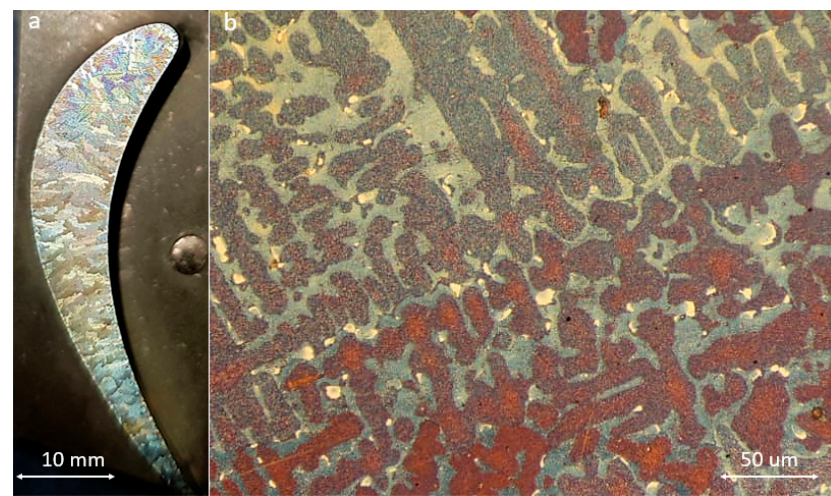
Figure 2. ( a ) Macro and ( b ) optical microscope images of failed blades.